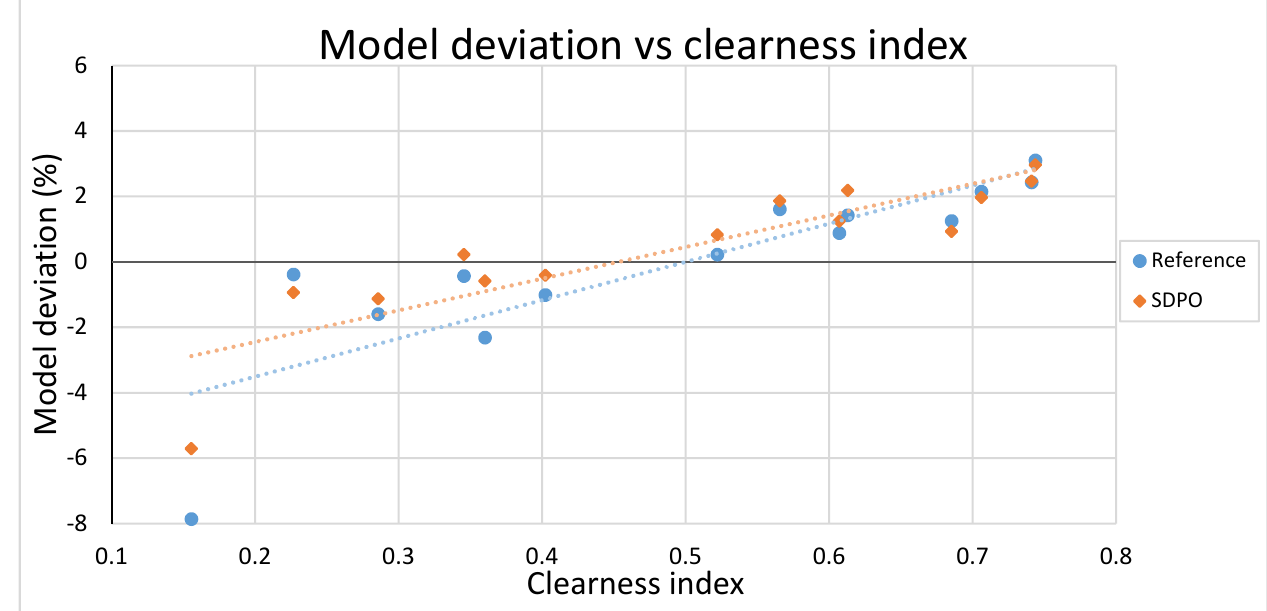
Figure 14. Deviation of simulated and measured energy yield with the clearness index.